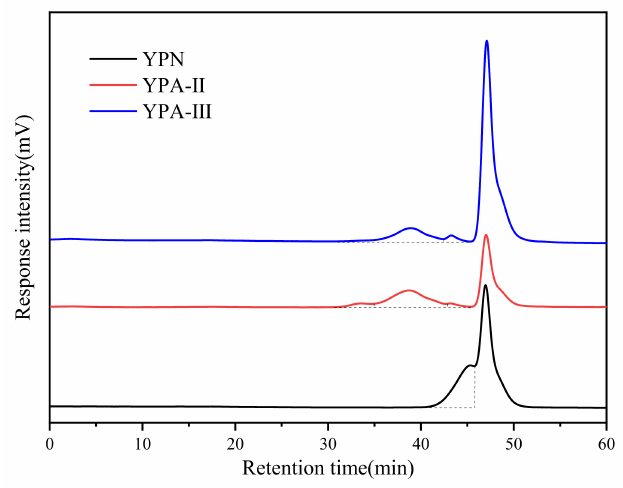
Figure 3. HPGPC profiles of yam polysaccharide fractions. The peak near 46.9 min is attributed to the mobile phase (0.05 mmol/L NaCl). Table 2. Molecular weight data analysis of yam polysaccharide fractions. Polysaccharide